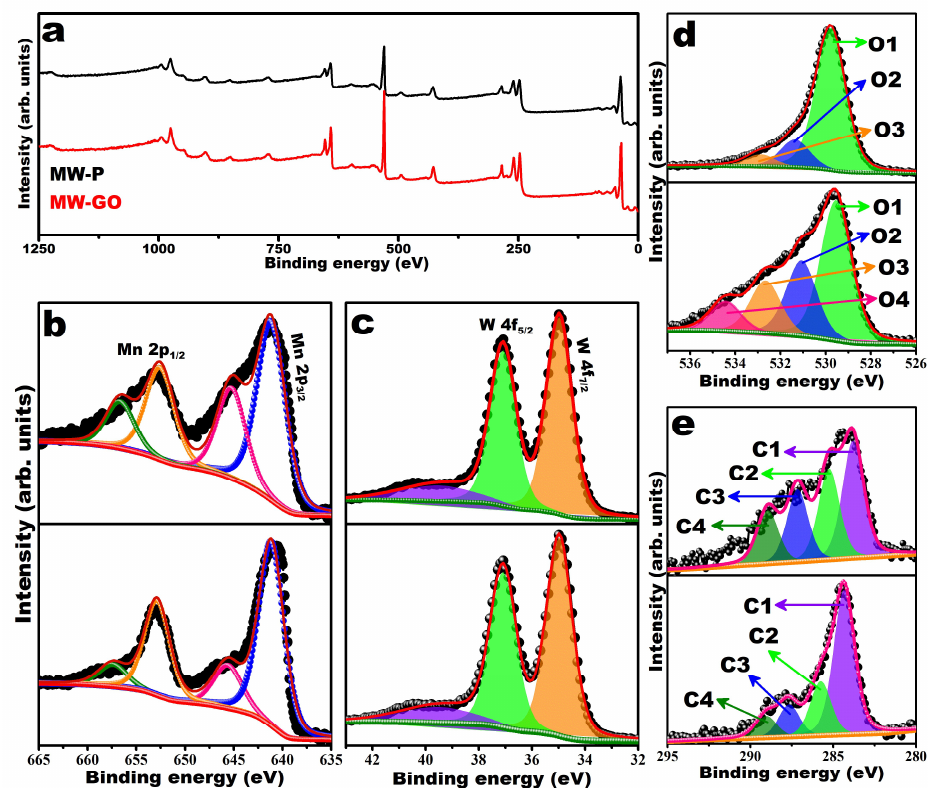
Figure 3. XPS analysis of MW-12 (above) and MW@GO-12 (below), survey scan spectrum ( a ), Mn-2p of MW-12 (above) and MW@GO-12 (below) ( b ), W 4f of MW-12 (above) and MW@GO-12 (below) ( c ), O 1s of MW-12 (above) and MW@GO-12 (below) ( d ), and C 1s of MW-12 (above) and MW@GO-12 (below) ( e